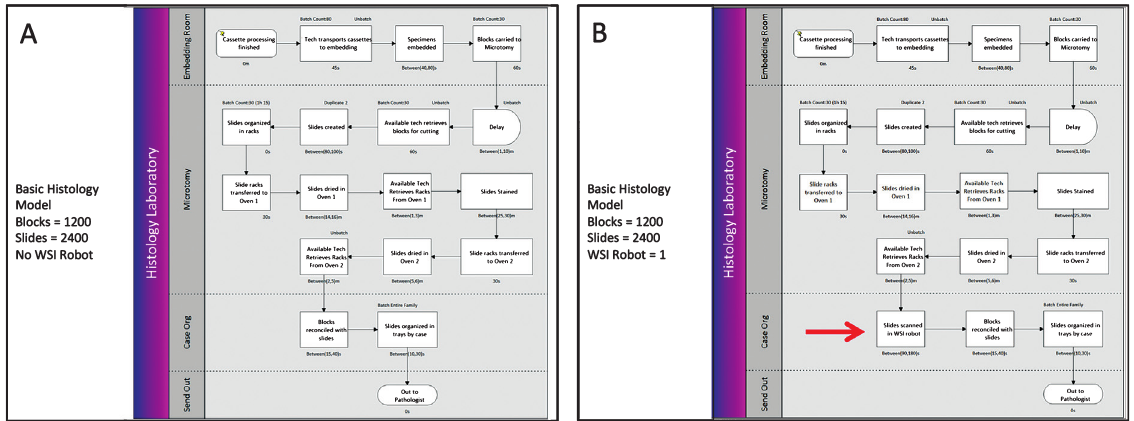
Fig. 1. (A) Histology simulation models without WSI robot and (B) with WSI robot.